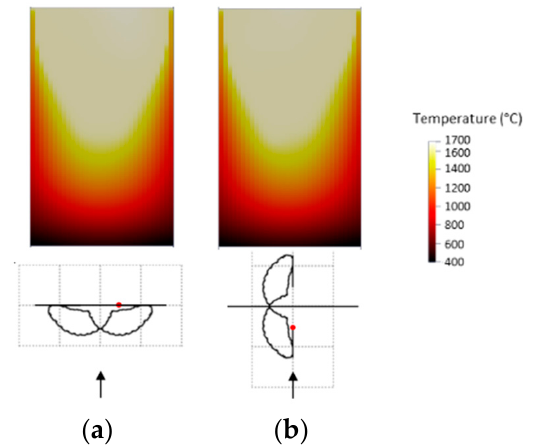
Figure 11. Distributions of the metal temperature in two perpendicular transverse sections ( a ) 𝑦 = 0 and ( b ) 𝑥 = 0 of the ingot at the same time instant considered in Figure 10.